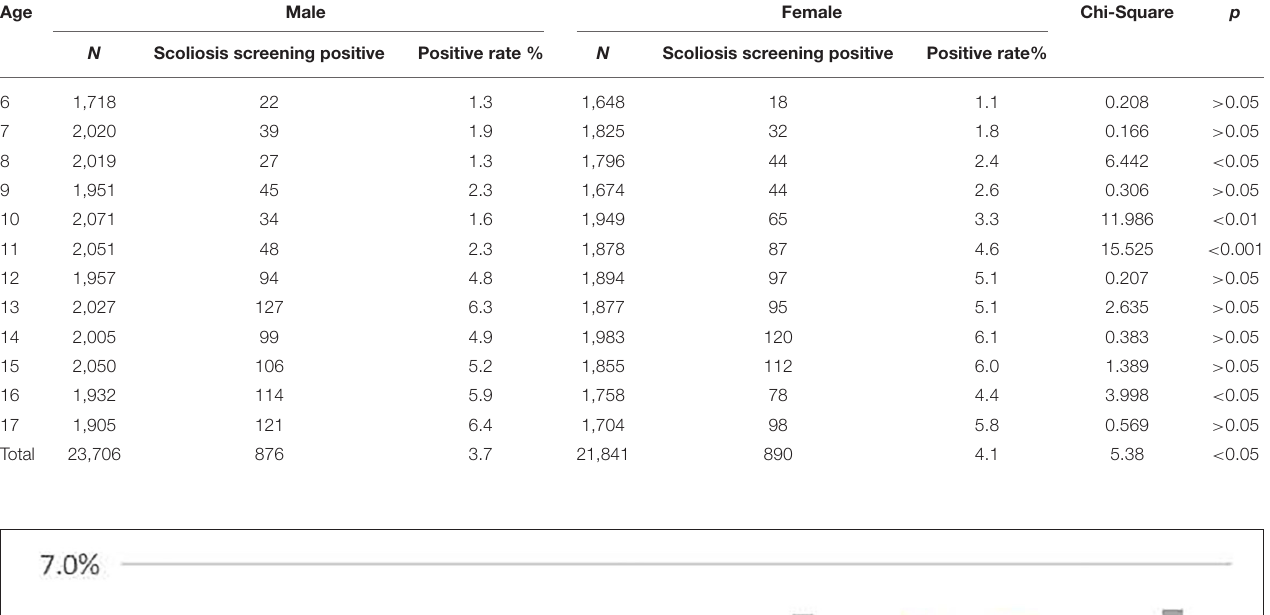
TABLE 2 | The prevalence of scoliosis screening is positive among students stratified by gender. Age Male Female Chi-Square